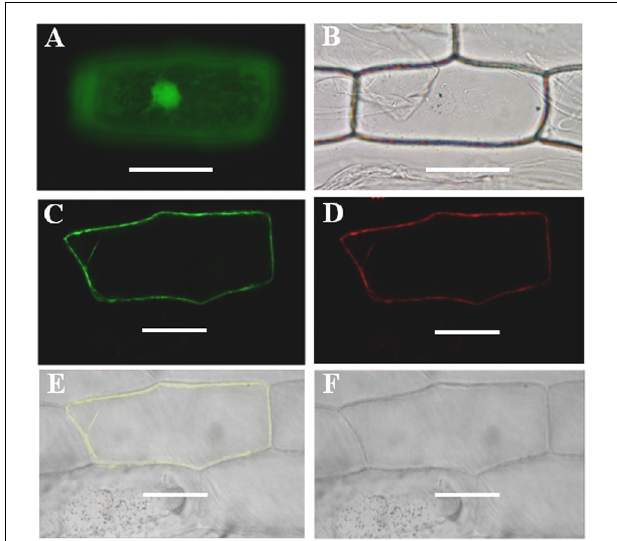
FIGURE 1 | Subcellular localization of GmPIP2;9. (A,B) Onion epidermal cells expressing green fluorescent protein (GFP). (A) GFP signals in the nucleus, cytoplasm, and plasma membrane (PM). (B) Bright-field light image. (C) Onion epidermal cells expressing GmPIP2;9-GFP with GFP signals in the PM. (D) Onion epidermal cells expressing red fluorescent signal from the CD3-1007 PM marker. (E,F) Merged fluorescent and bright-field images of an epidermal cell expressing the GmPIP2;9-sGFP fusion protein and the CD3-1007 PM marker. Bars = 100 µ